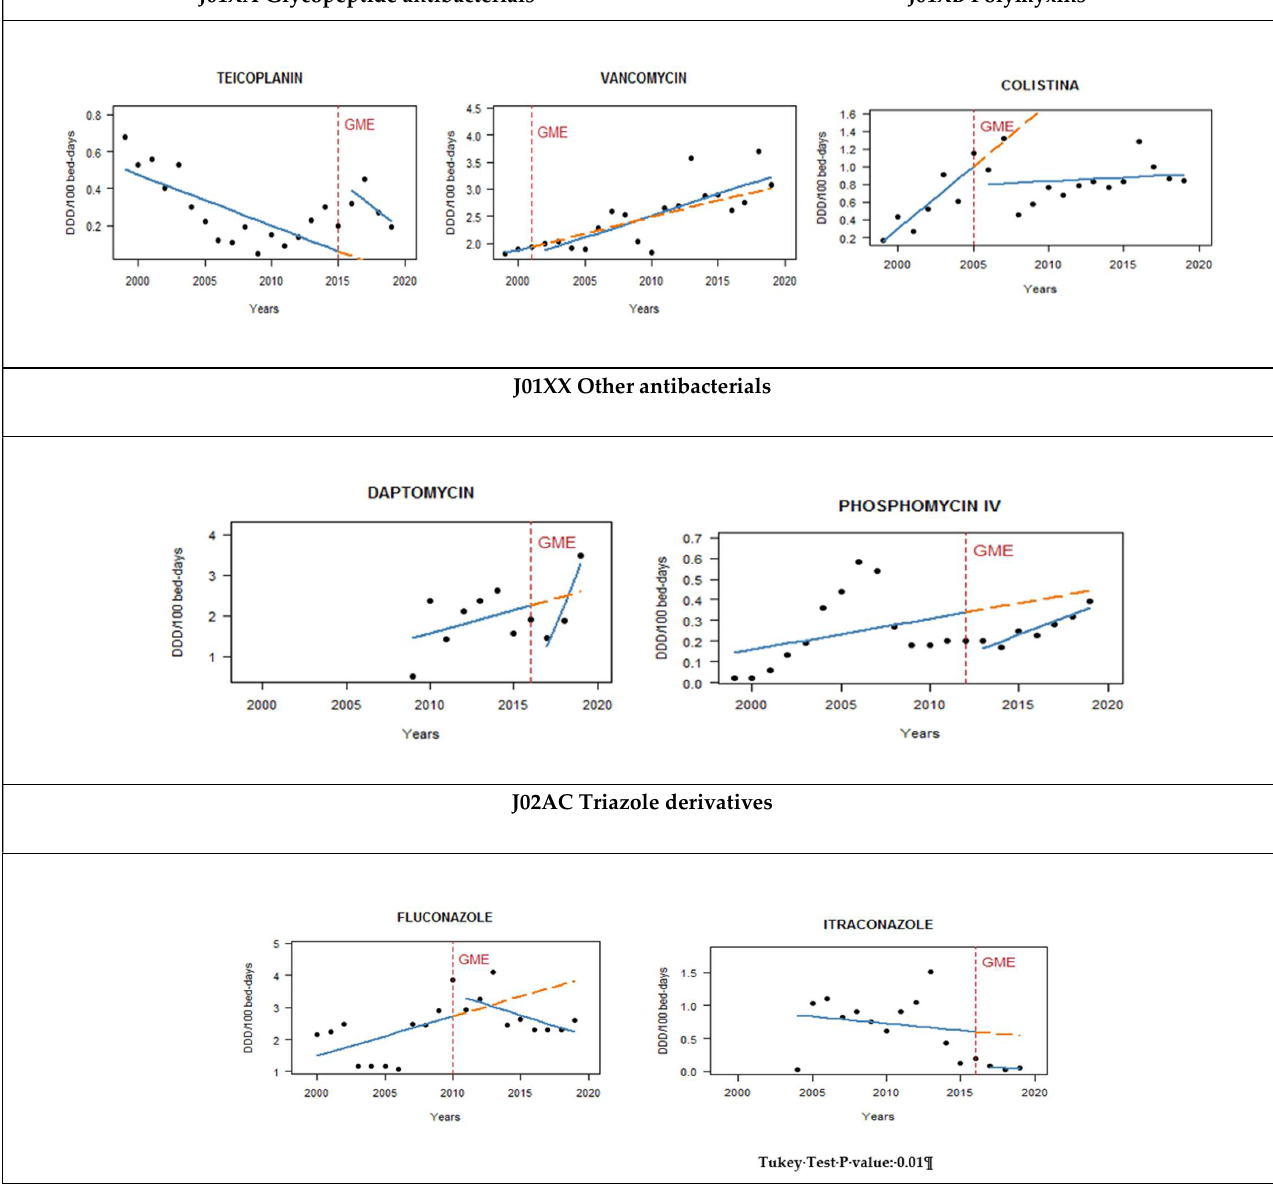
Figure 1. Antimicrobial consumption evolution after generic market entry: DDD—defined daily doses, GME—generic market entry.